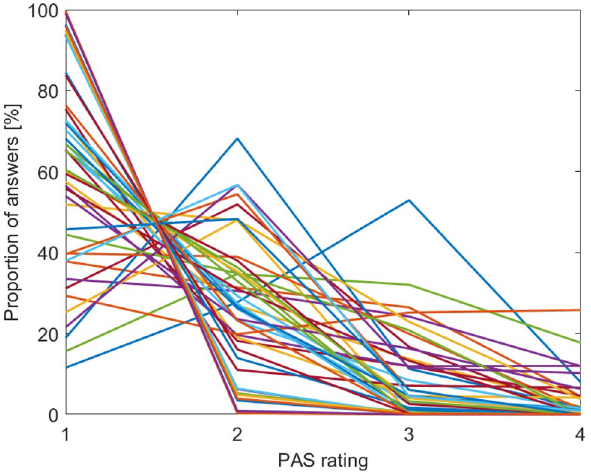
Figure 3. Visibility rating (Experiment2). Figure shows proportions of perceptual awareness scale (PAS) ratings: 1—not seen, 2—weak glimpse, 3—almost clear, 4—clear image. Each line represents an individual